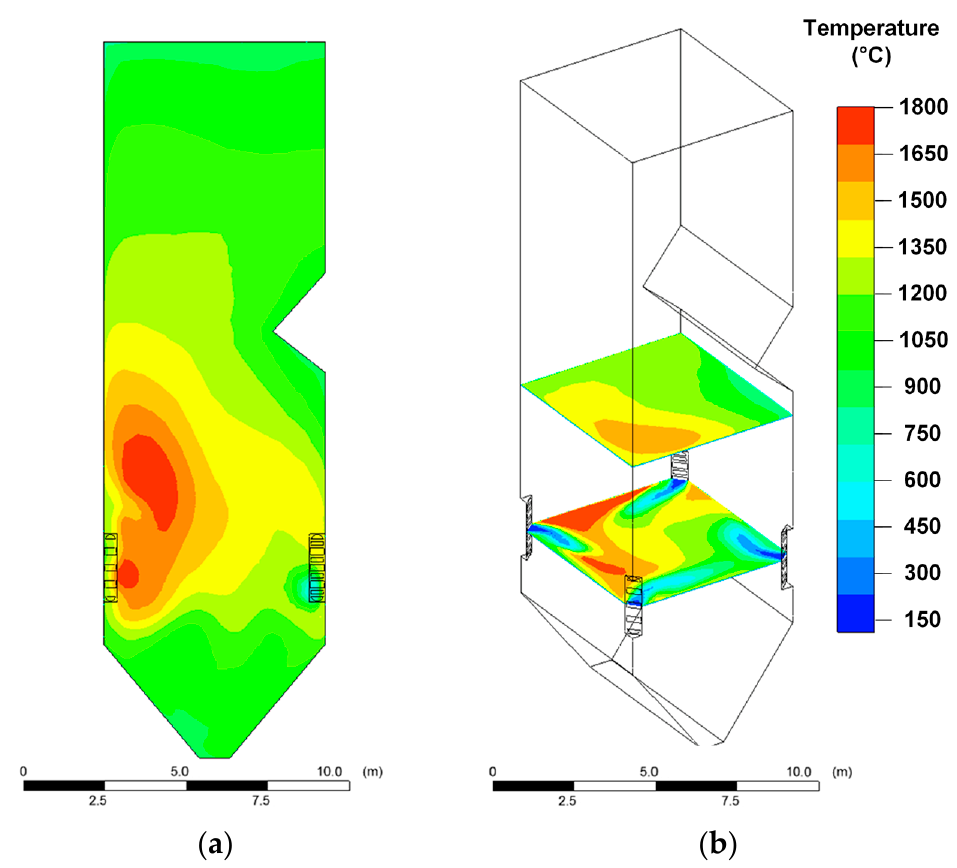
Figure 3. Typical temperature fields in the boiler furnace when burning coal: in the longitudinal section ( a ); in the cross sections ( b